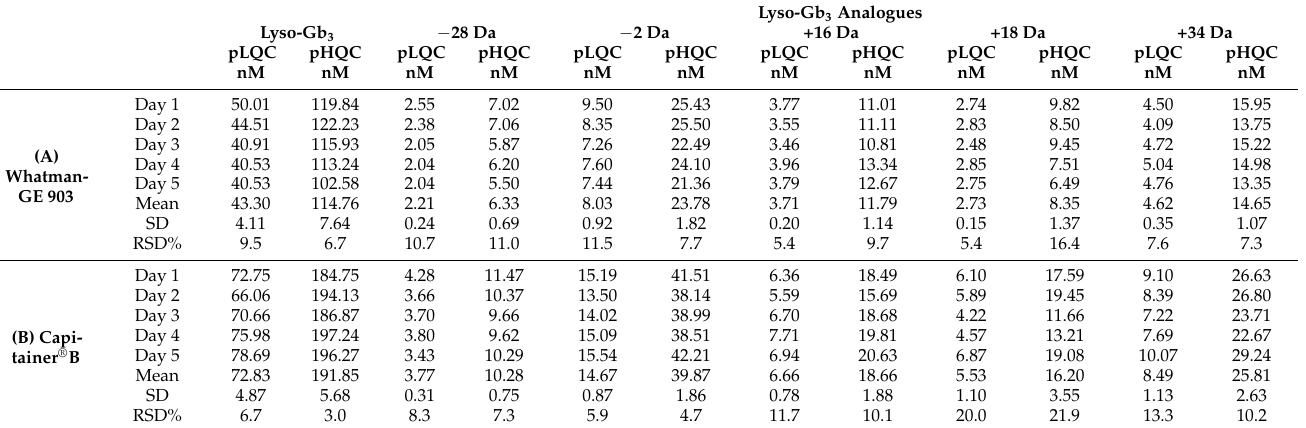
Table 4. Inter-day ( n = 5) assays performed with dried blood spots (DBSs) obtained from Fabry patients as quality controls (pQCs).